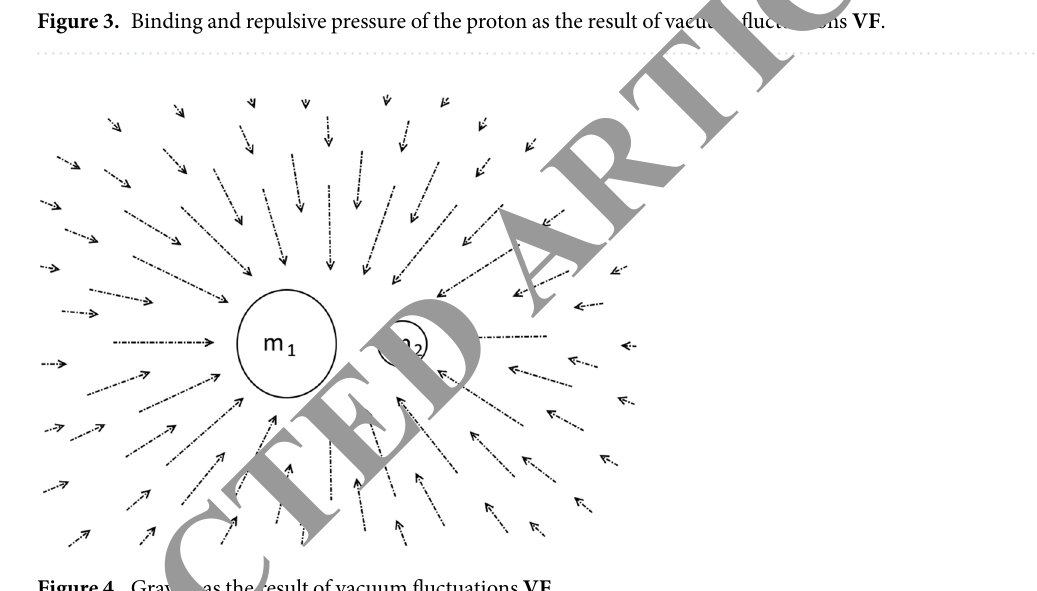
Figure 4. Gravity as the result of vacuum fluctuations VF